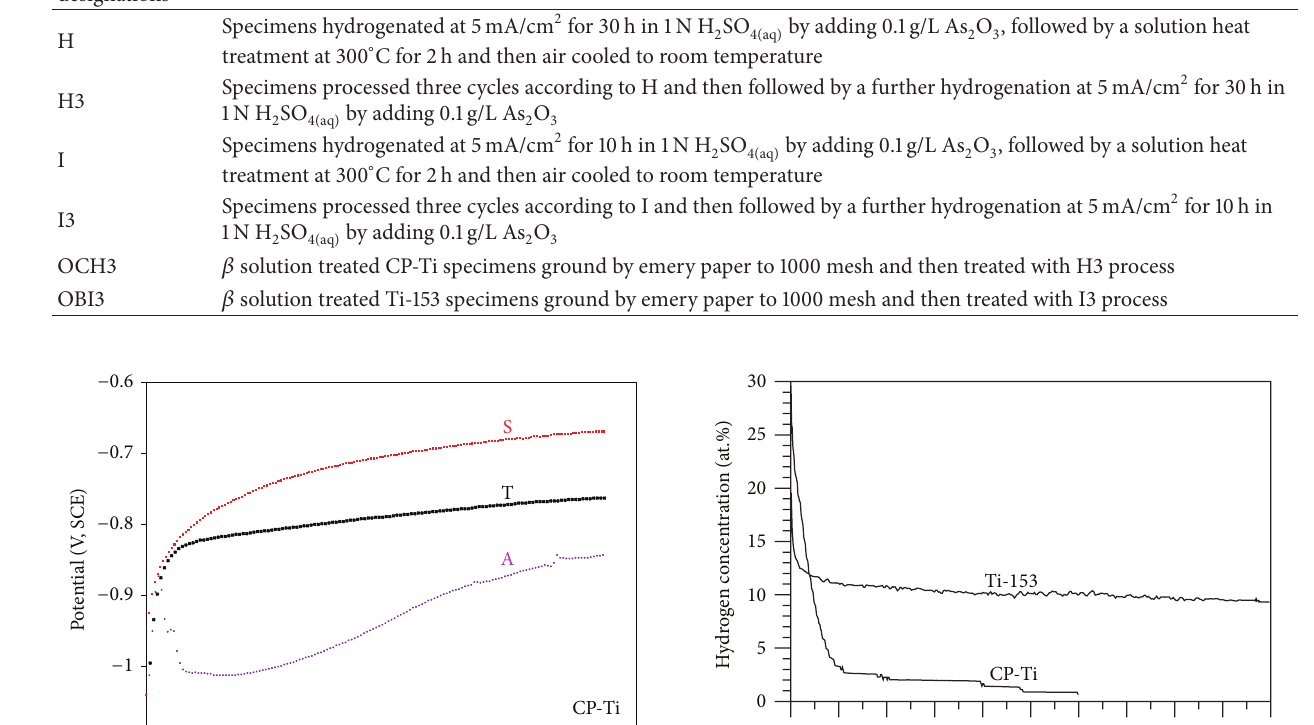
Table 4: Designations and the associated parameters of the cyclic hydrogenation-solution treatments. Process